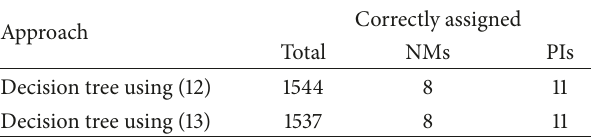
Table 16: Decision tree classification